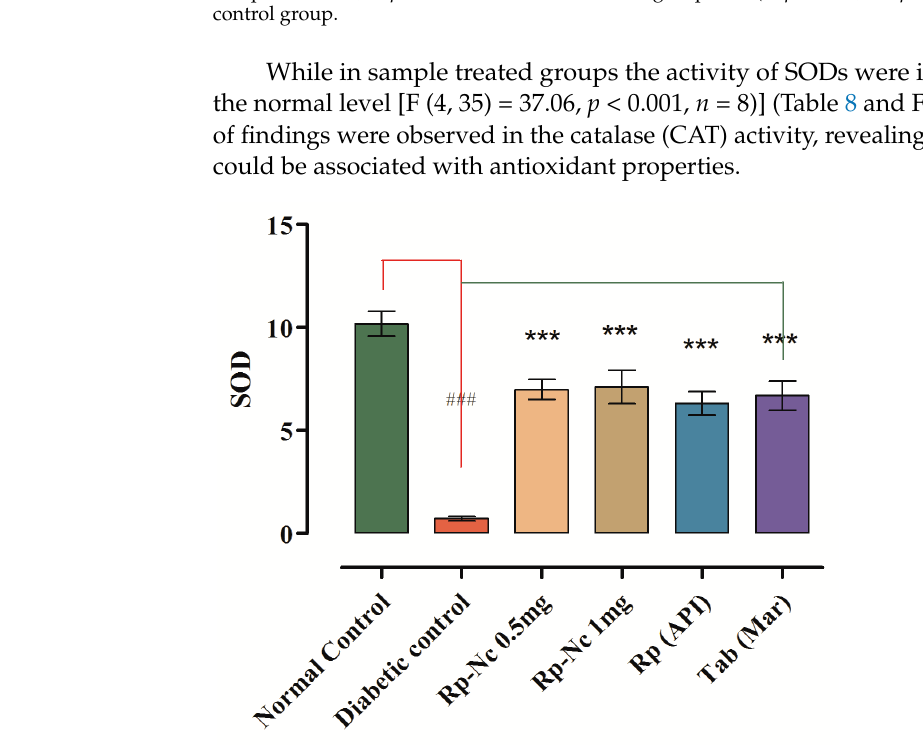
Figure 8. Effect of Rp-Nc on SOD level. Mean ± SEM ( n = 8). Significance was determined statisti ‐